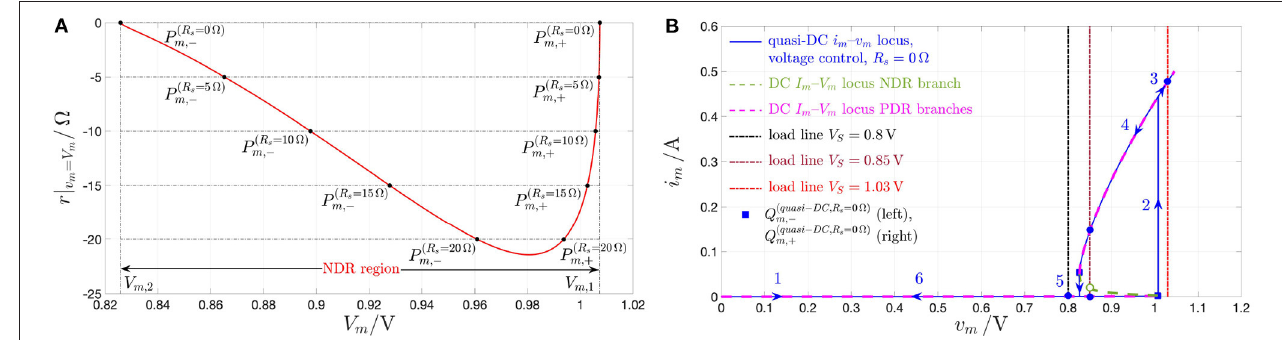
(in red) vs. memristor DC voltage V m for all the possible NDR DC operating points of the threshold switch (refer also | v m = V m r of the small-signal resistance in the NDR region, the horizontal line r ˜ and P ( R s =−˜ r ) m , , enclosing the set of NDR operating points, which would not be stabilized by the insertion of a linear resistor − +